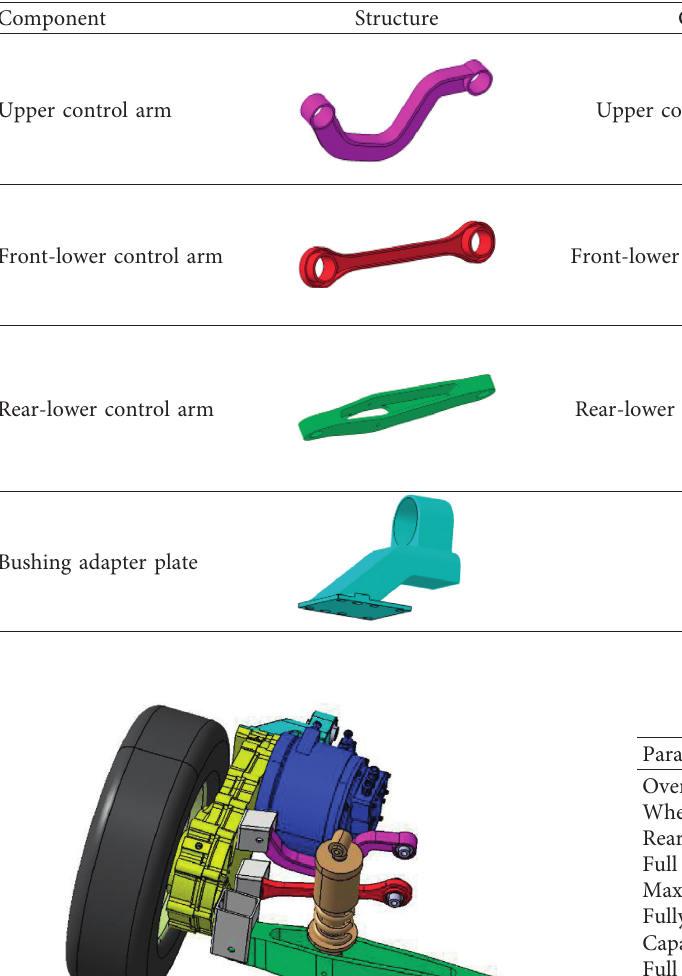
Table 13: Structural design of each component.